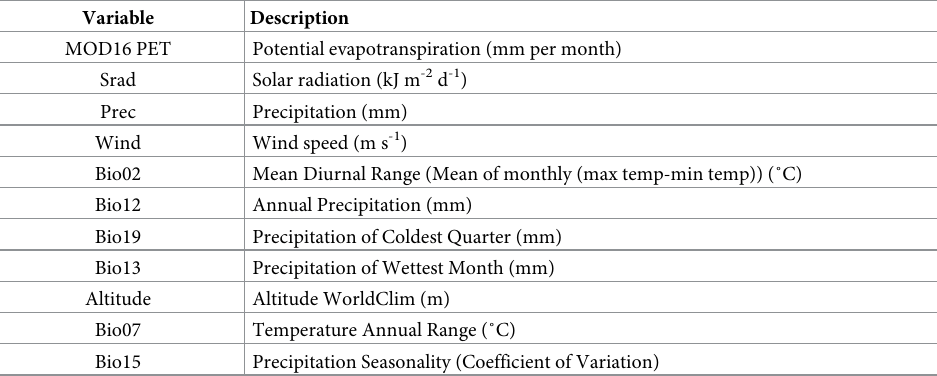
Table 2. Variables selected for training of the models according to the Recursive Feature